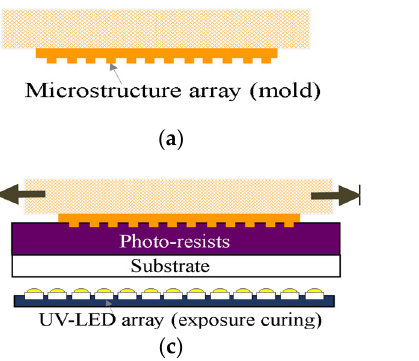
( d ) Figure 8. SIN waveforms: ( a ) A, ( b ) A’, ( c ) B, and ( d ) B’ types. ANSYS software was used for uniaxial stretching simulation to analyze strain and geometric characteristics. The set material simulation parameters used in the simulations were as follows: density, 1.063 g/cm 3 ; Young’s modulus, 2.4622 Mpa; and Poisson’s ratio, 0.5. The simulation results of the SIN waveforms with 2.5 mm of uniaxial stretching show different total deformation, strain, and stress in the four groups, as shown in Figure 9.